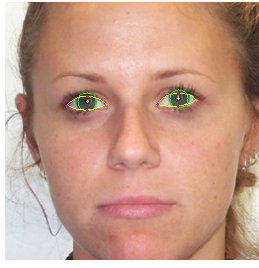
Figure 12. Eye shape segmentation results.